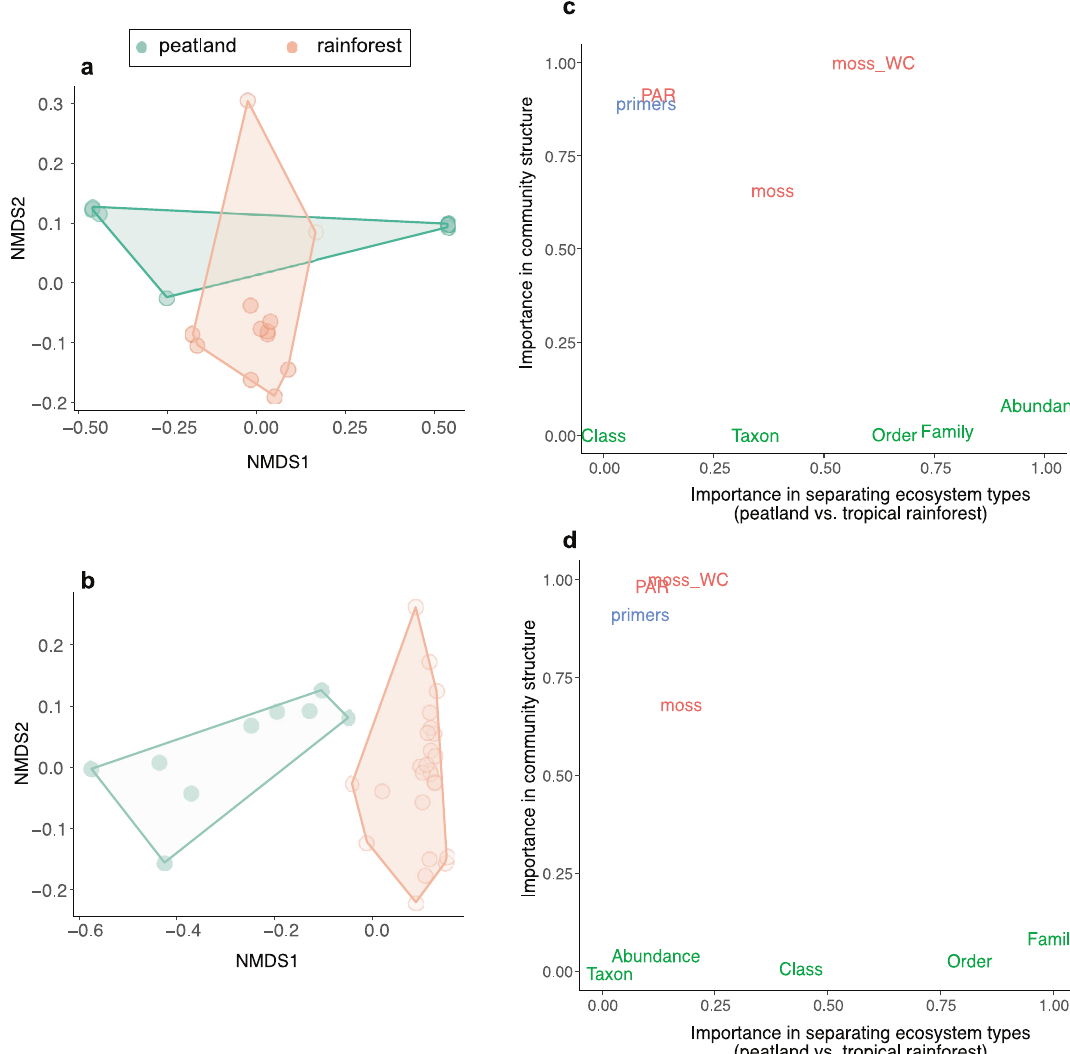
Fig. 2 Divergence of photosynthetic bacterial and protists community structure between the boreal peatland and the tropical rainforest and their drivers. NMDS of the communities of photosynthetic bacteria and protists based on 16 S and 18 S gene amplicon sequencing data, respectively ( a , b ). Variables of importance from random forests models used to classify each type bryosphere based on the relative abundance of taxa (in green), environmental (in red) and technical variables (in blue) under unsupervised (x-axis) and supervised (y axis) mode, and including primers (reward and forward), bryophyte identity, bryophyte water content (%) and light availability ( c , d ). All values are variable importance from Random Forest models (normalized Gini index, see Methods); points that are further to the right on the x axis have more importance in separating studies, whereas points that are higher up on the y axis have more importance in community